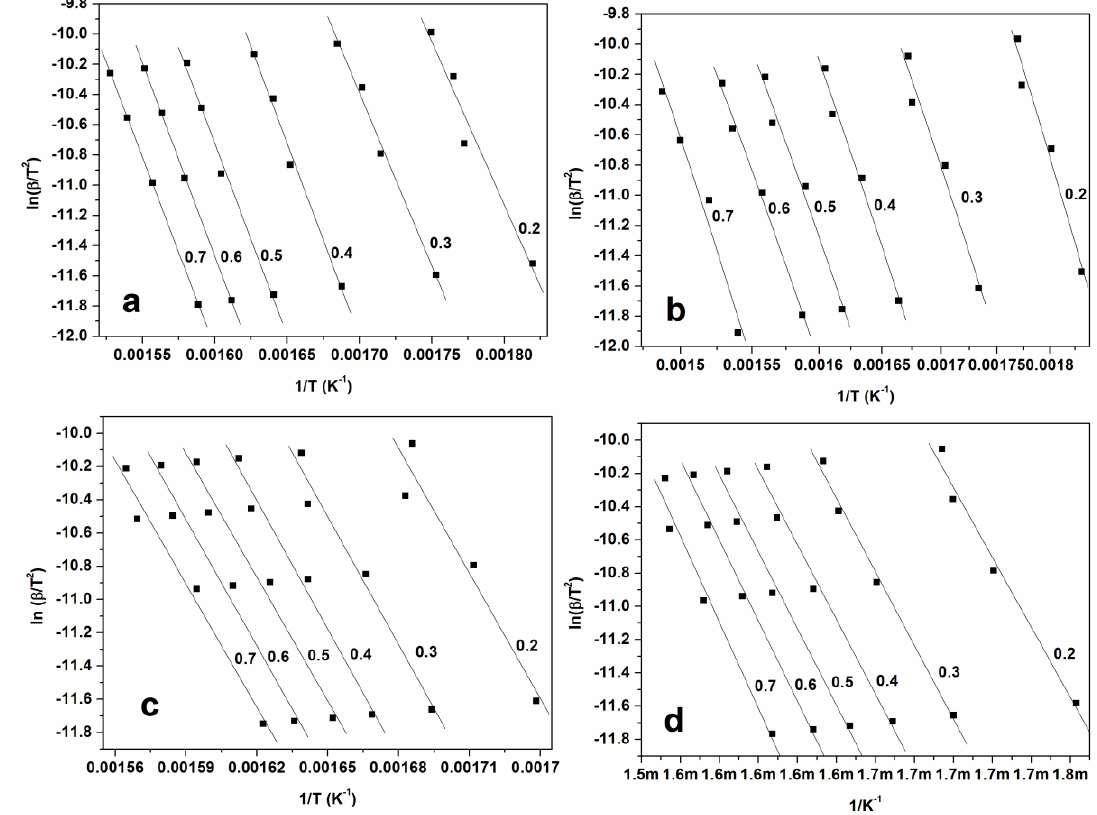
Figure 6. ( a ) KAS of Untreated SCB; ( b ) KAS of untreated SW; ( c ) KAS of SBC cellulose; ( d ) KAS of SW cellulose.